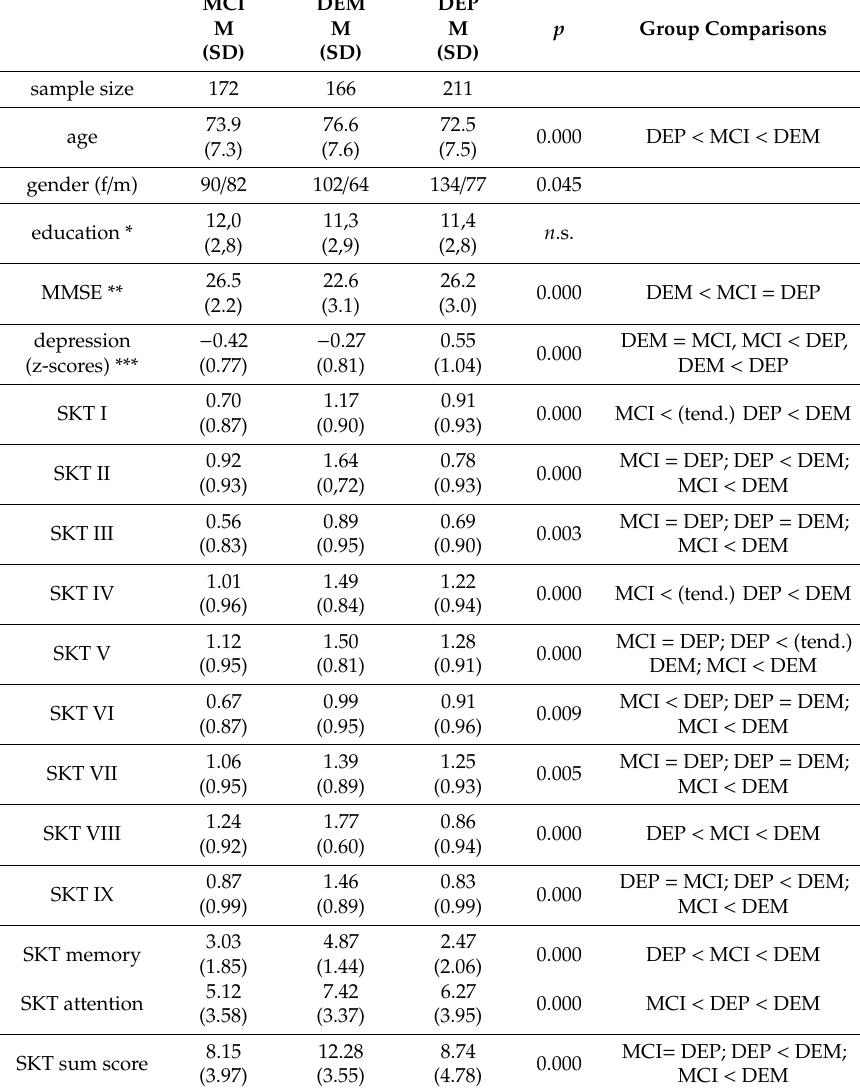
Table 2. Demographic data, Mini-Mental State Examination (MMSE) and depression scores, SKT norm scores for subtests I to IX, SKT subscores for memory and attention and SKT total score. Frequencies (sample size and gender) or mean values with standard deviations in brackets are